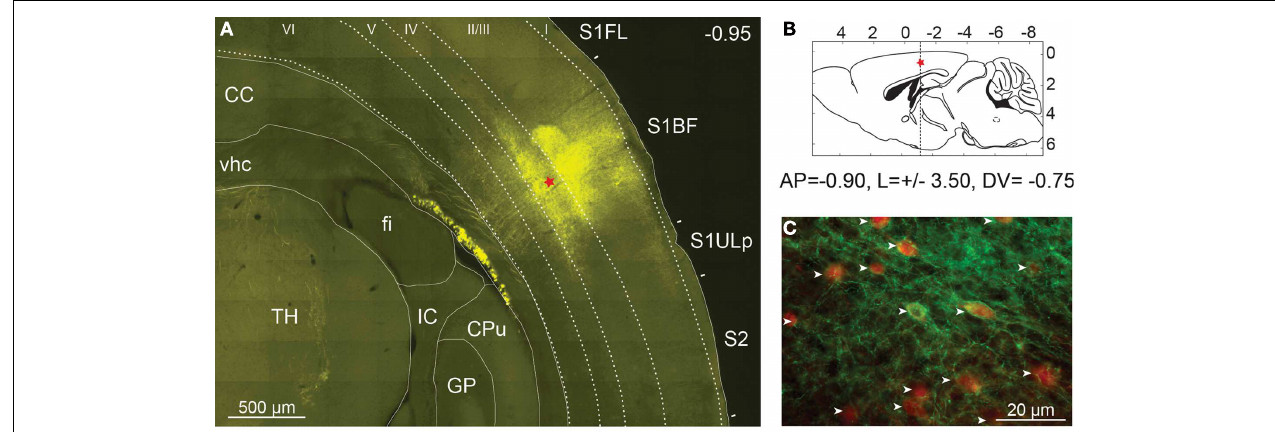
FIGURE 2 | Expression of ChETA-EYFP in the cerebral cortex of mice. (A) High resolution mosaic images of around 100 individual frames obtained from a 50- µ m thick coronal section of PV::Cre mouse cerebral cortex after 14days of rAAV infection. Level of expression in somatosensory cortex was controlled by fluorescence microscopy (EYFP filter).The red star indicates the injection site.TH, thalamus; fi, fimbria of hippocampus; vhc, ventral hippocampal commissure; CC, corpus callosum; GP, globus pallidus; IC, internal capsule; CPu, caudate putamen, S1FL, primary